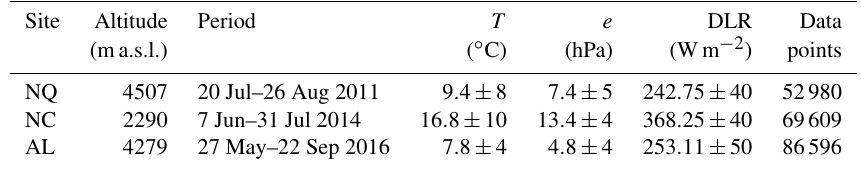
Table 1. Description of stations and measurements (magnitude and variability) at three stations in the Tibetan Plateau. Site Altitude Period T e DLR Data (ma.s.l.) ( ◦ C) (hPa) (Wm − 2 ) points NQ 4507 20 Jul–26 Aug 2011 9 . 4 ± 8 7 . 4 ± 5 242 . 75 ± 40 52980 NC 2290 7 Jun–31 Jul 2014 16 . 8 ± 10 13 . 4 ± 4 368 . 25 ± 40 69609 AL 4279 27 May–22 Sep 2016 253 . 11 ± 50